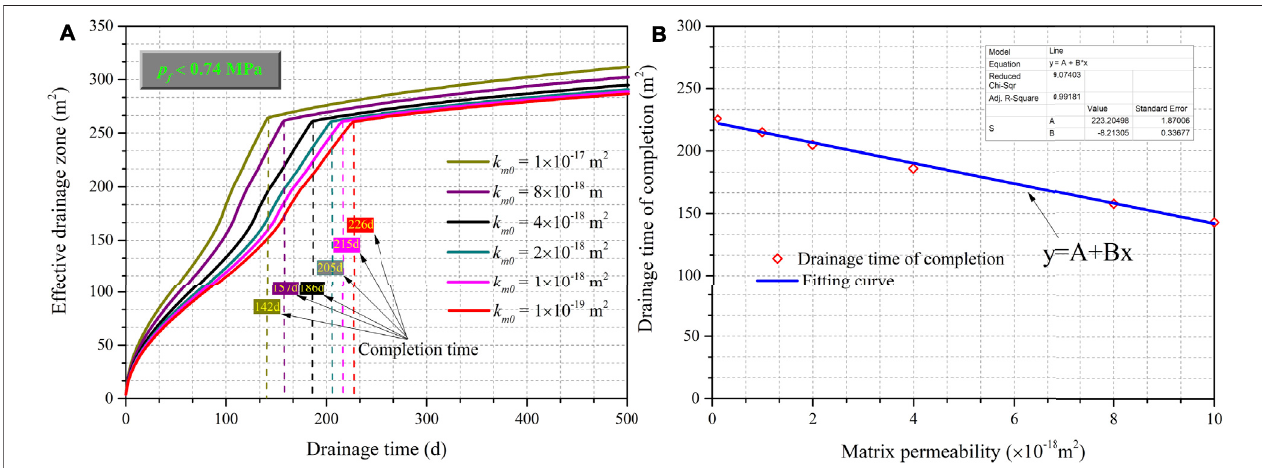
FIGURE14 | Effect ofmatrix permeability on thedrainage performance. (A) Effective drainage zone versus vs. drainage time in days. (B) Drainage completion time vs. matrix permeabilities.